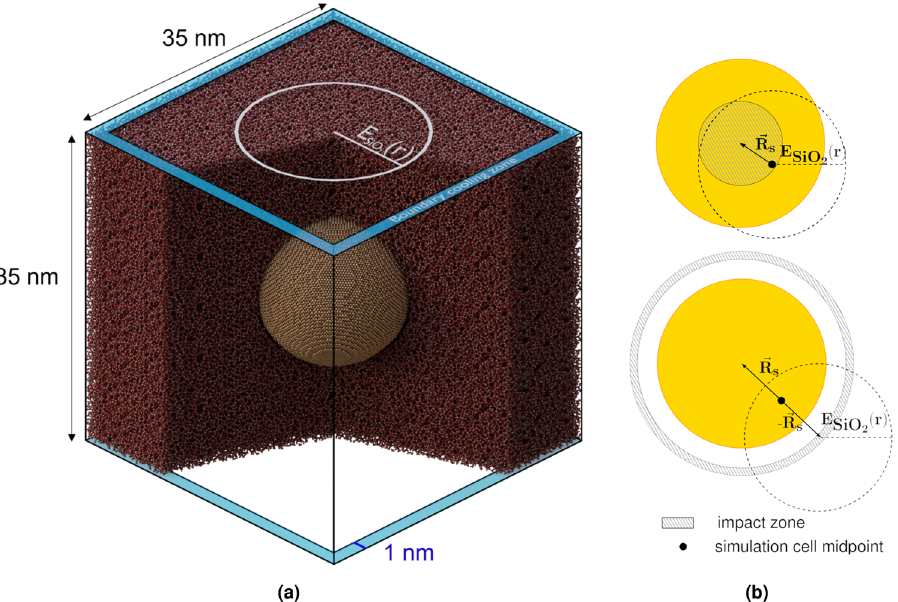
Figure 2. Schematics of the simulation. ( a ) Indicated in the figure are the radial symmetry of the energy deposition profile in silica, cell dimensions, and the width of the boundary cooling volume at the edges of the simulation cell. The radius of the crystalline NP is 8 nm. ( b ) The upper figure shows the region where ions hit (cid:31) R the NP. It also shows an example translation, s , over the periodic boundary to obtain an impact location within |� R the zone. In this case, s | max = 4 nm. The lower figure shows the translation when the ions hit outside the NP. The radial energy deposition profile is also shifted as indicated. The distance from the ion trajectory to the center |� R of the NP is 12 nm, i.e. s | = 6